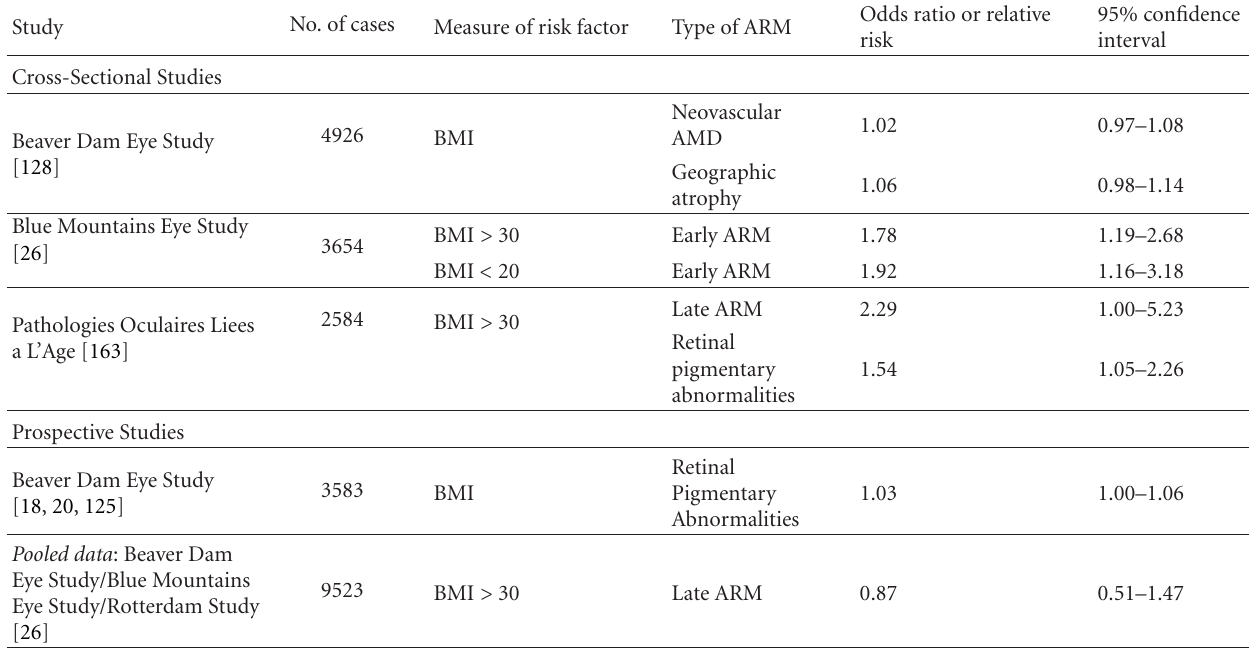
Table 6: Studies investigating the relationship between obesity and risk for